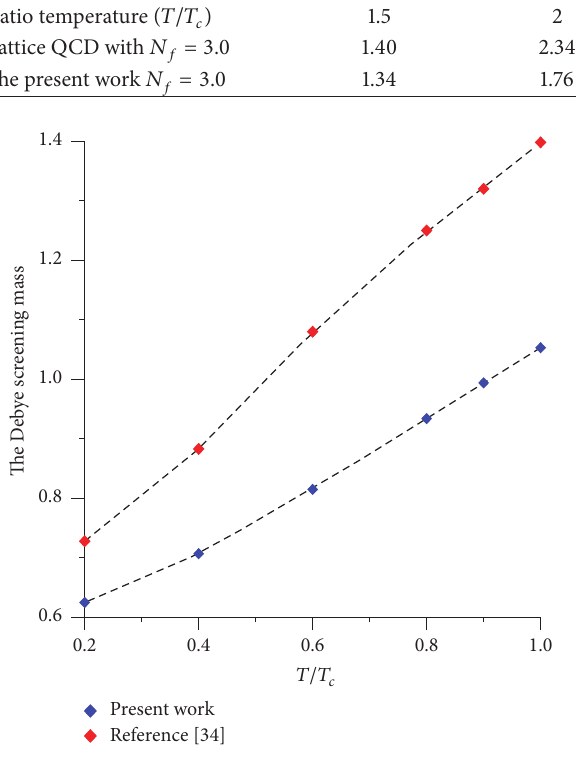
Figure 2: The Debye screening mass is a function of ratio tempera- ture at 𝑚 𝑐 = 1640